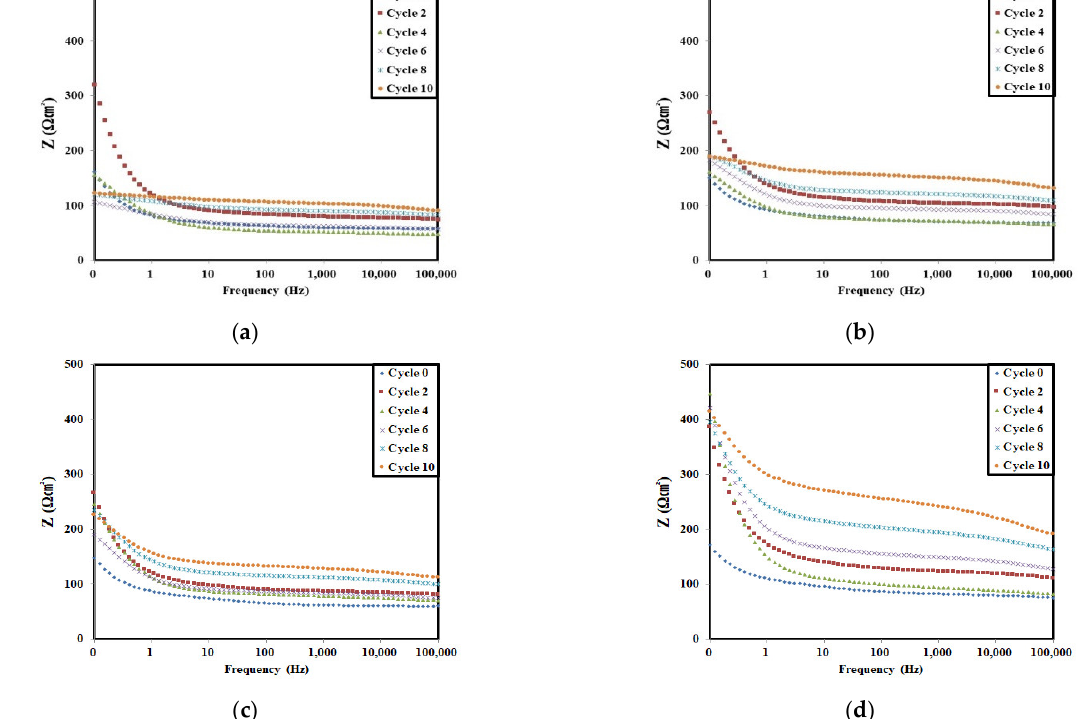
Figure 7. Bode modulus plot of the rebars embedded in concrete according to the corrosion acceleration cycle: ( a ) normal, ( b ) C12, ( c ) C12N6, and ( d ) C12N12.